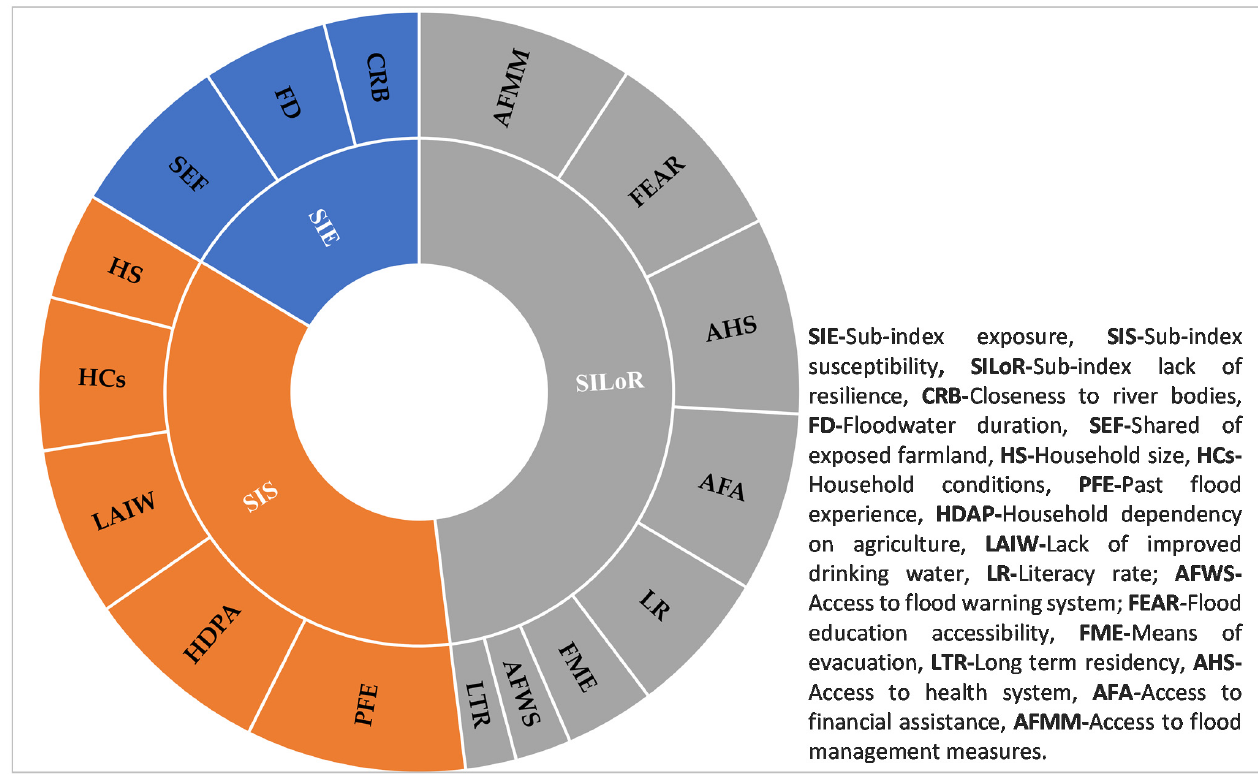
Figure 5. Contributors in the flood vulnerability index in the study area for intervention planning.